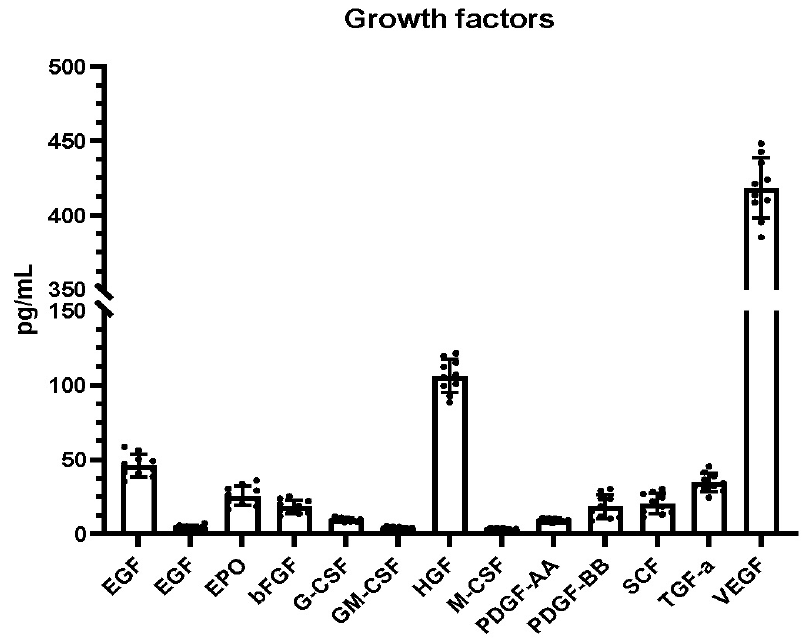
Figure 2. DPMSC-CM growth factor profile after 48 h incubation with DMEM + 0.2% FBS. VEGF: Vascular endothelial growth factor, TGF-α: Transforming growth factor-alpha, SCF: Stem cell factor, PDGF-AA: Platelet-derived growth factor AA, PDGF-BB: Platelet-derived growth factor-BB, HGF: Hepatocyte growth factor, FGF basic: Basic fibroblast growth factor, EPO: Erythropoietin, EGF: Epidermal growth factor, Ang-2: Angiopoietin-2, G-CSF: Granulocyte colony-stimulating factor, GM-CSF: Granulocyte-macrophage colony-stimulating factor, M-CSF: Macrophage colony-stimulating factor.